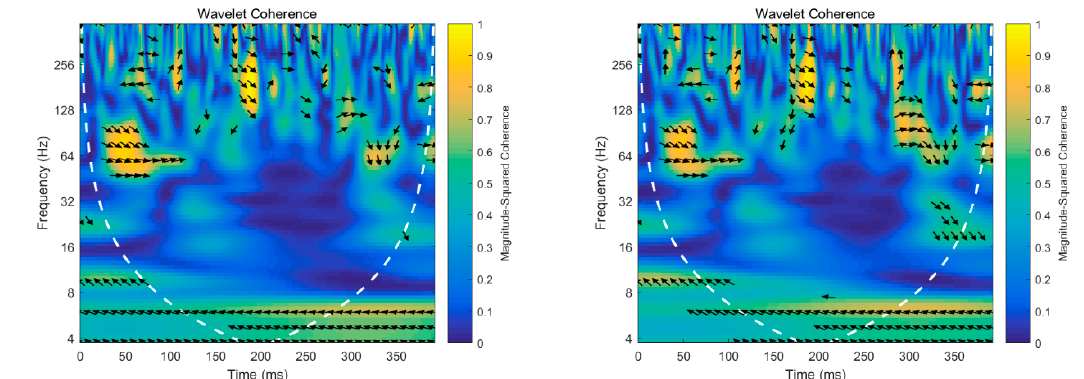
Figure 4. Wavelet coherence between the GPR index and crude oil prices. Note: the left sub-plot and the right sub-plot represent wavelet coherence of the GPR-Brent pair and GPR-WTI pair, respectively. The sample period is from June 1987 to February 2020.